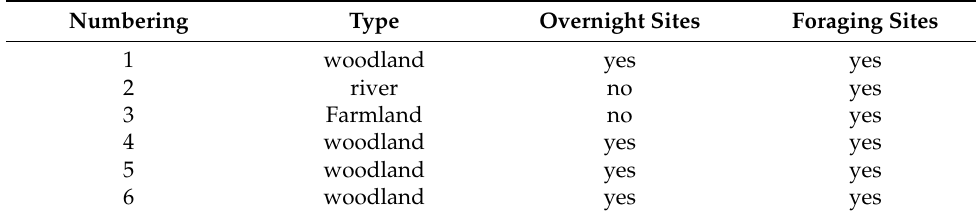
Table 2. Crested ibis overnight and foraging sites identified by field